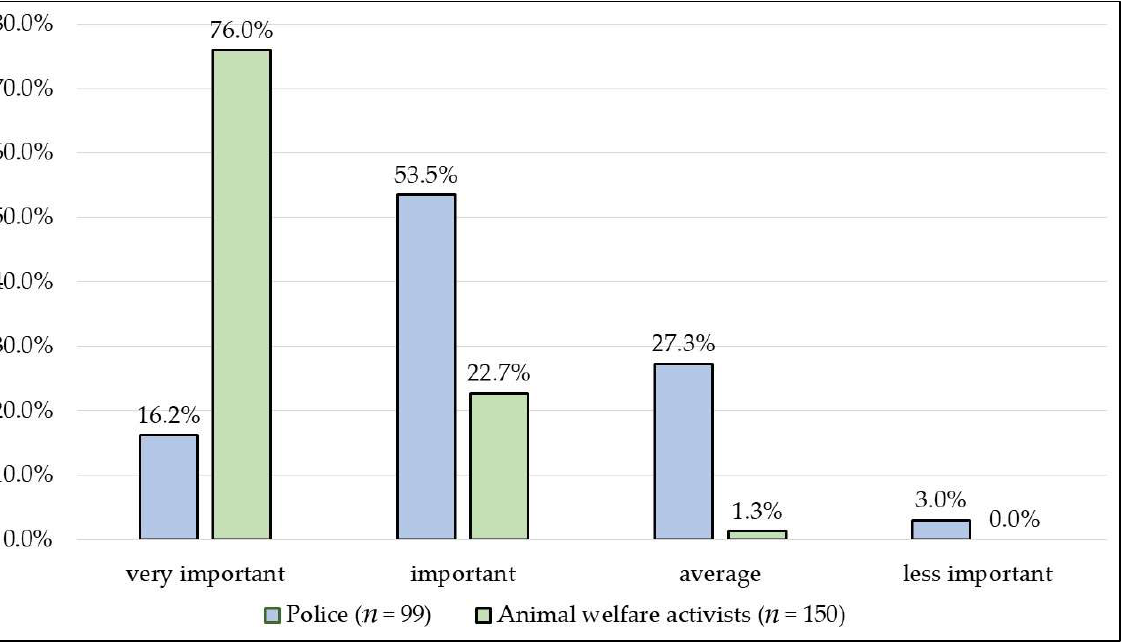
Figure 2. The importance of animal cruelty as a felony, according to police offices and animal welfare